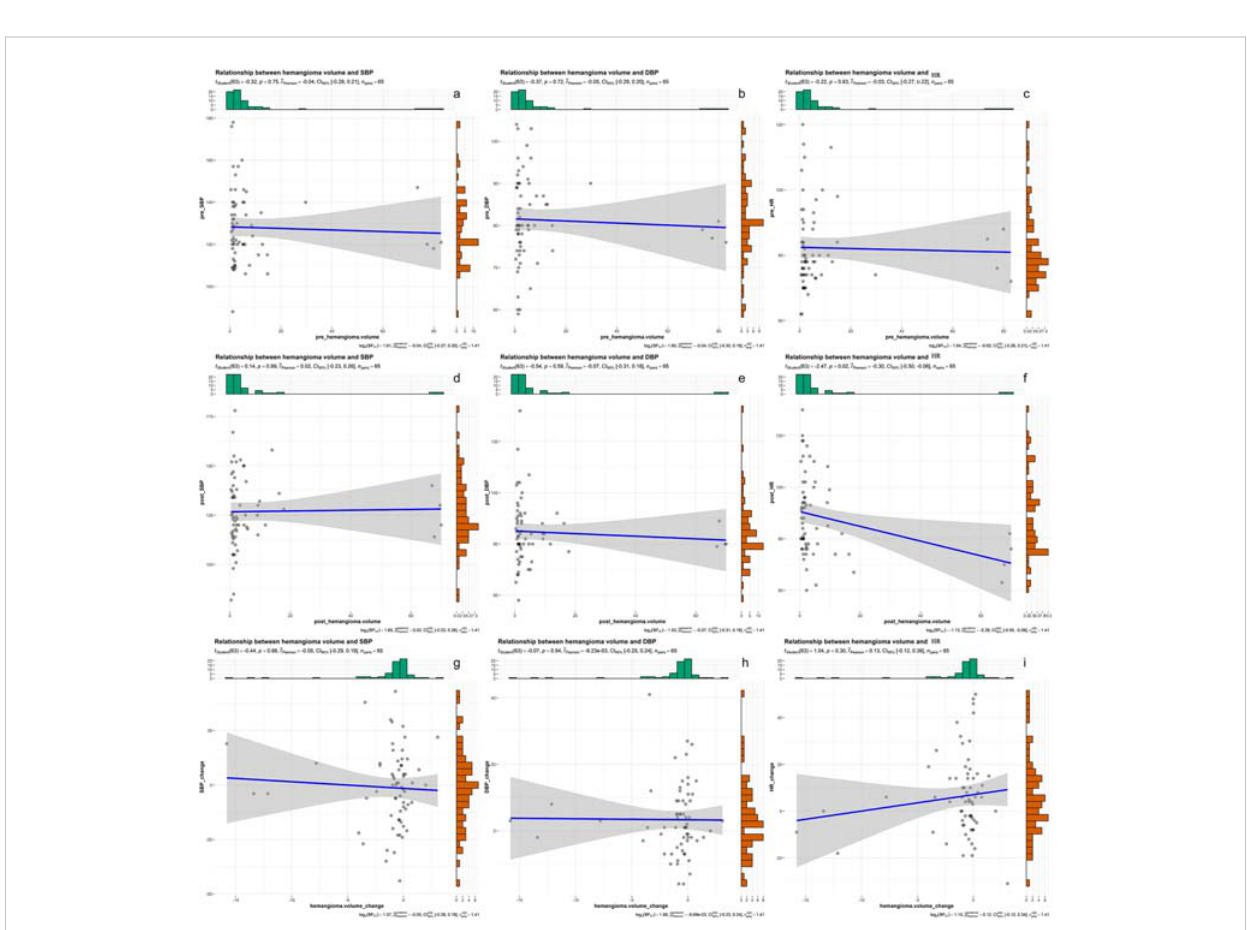
FIGURE 6 (A – C) the correlation results of systolic blood pressure, diastolic blood pressure, heart rate and hemangioma volume before bevacizumab treatment. (D – F) the correlation results of systolic blood pressure, diastolic blood pressure, heart rate and hemangioma volume after bevacizumab treatment. (G – I) the correlation results of changes in systolic blood pressure, diastolic blood pressure, heart rate and changes in hemangioma volume after bevacizumab treatment.